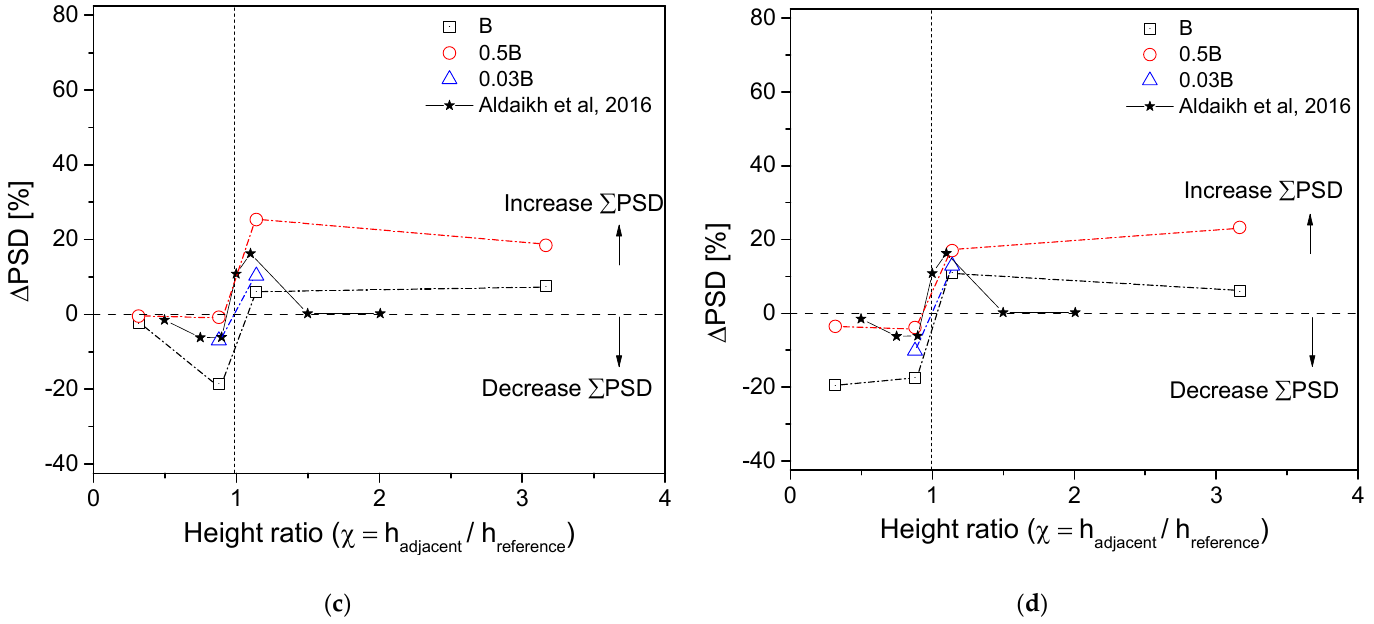
Figure 10. Variation of ΔPSD with height ratio suffered from ( a ) artificial EQ at L_Input; ( b ) Hachinohe EQ at L_Input; ( c ) artificial EQ at H_Input; and ( d ) Hachinohe EQ at H_Input.